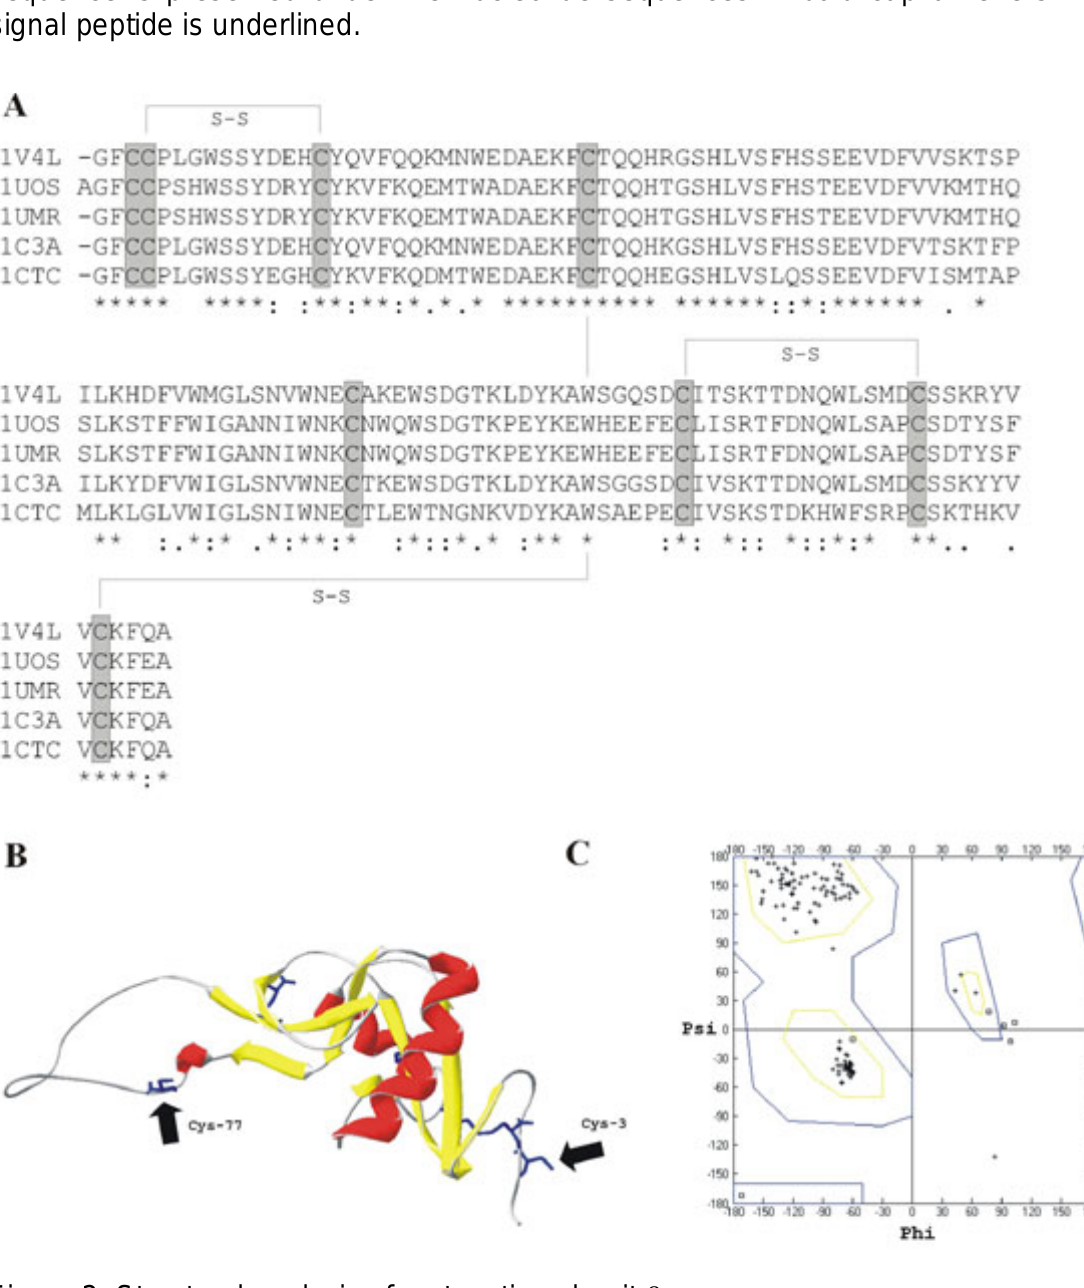
Figure 2: Structural analysis of crotacetin subunit β